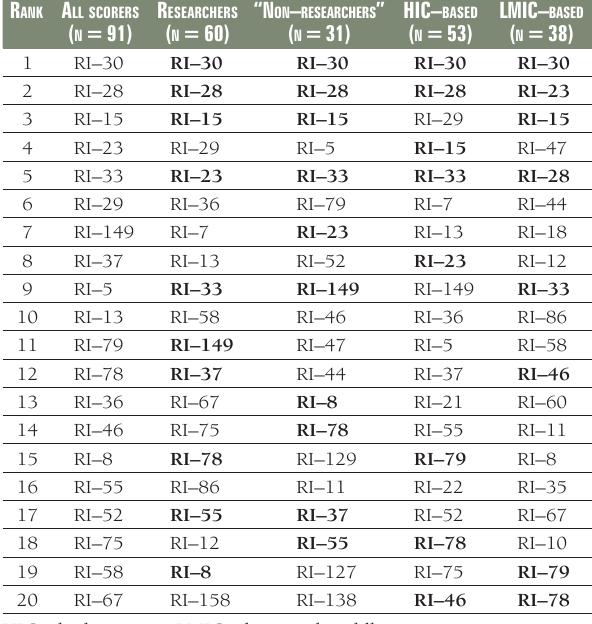
Table 2. The overlap between the top 20 research ideas (RI–) identified by different sub–groups of scorers (ie, researchers vs “non–researchers”; and HIC–based vs